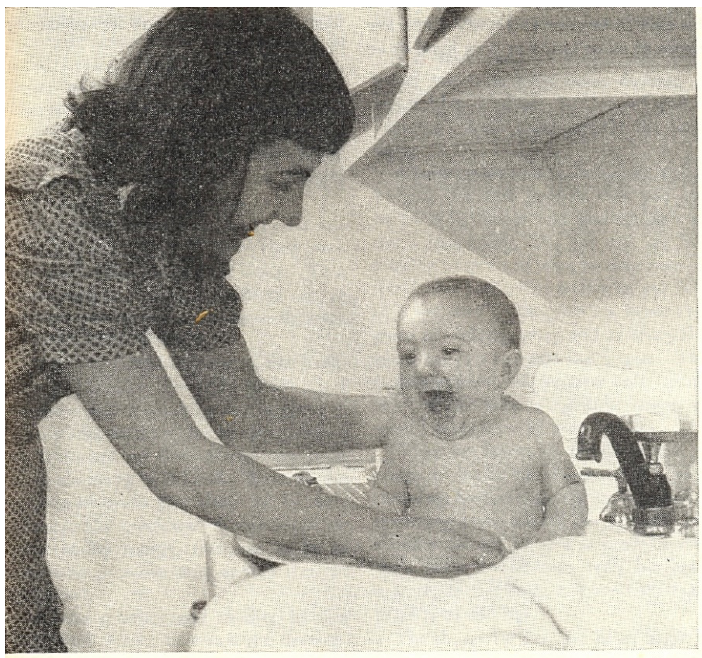
Figure 27. Bath Time is Play Time.